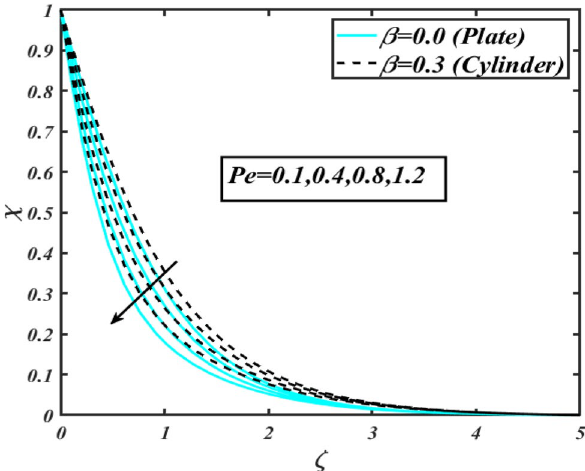
Figure 20. Profile of χ for Pe .